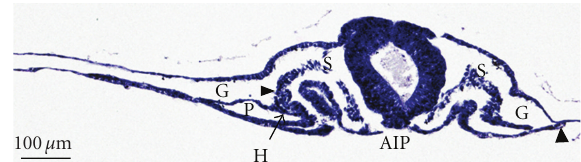
Figure 12: Section through a similar blastoderm as described in Figure 10(a), after 34 hours of culture. In the operated side (at the right of the figure), a mesoblast mantle is present in the intraembryonic cavity (G), which is closed as the result of the absence of junctional endoblast at that side. No blood islands and no coelomic cavity are formed. At the unoperated side, the intraembryonic cavity (G) is not interrupted laterally and contains blood islands close to the deep layer. Part of the coelomic cavity is visible (hemi-pericardial cavity: P) with unilateral primary heart anlage (H) in the neighbourhood of the infolding gut endoderm, laterally from the closing anterior intestinal portal (AIP). S, somites; arrowhead indicates intermediary mesoderm (nephrotome). Bar = 100 μ